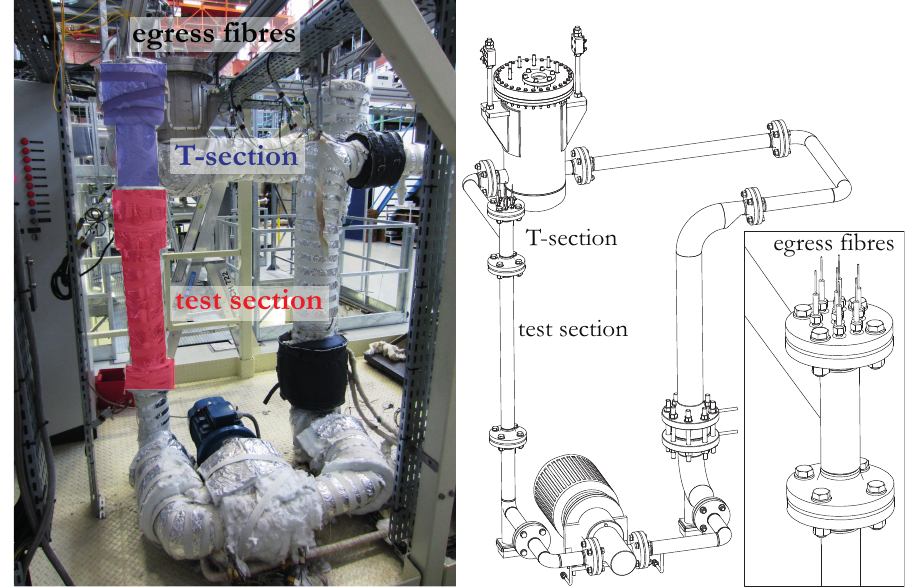
Figure 4. Photograph and scheme of the test facility containing the fuel assembly at SCK · CEN. The inset shows an enlarged image of the T-section holding the egress locations of the optical